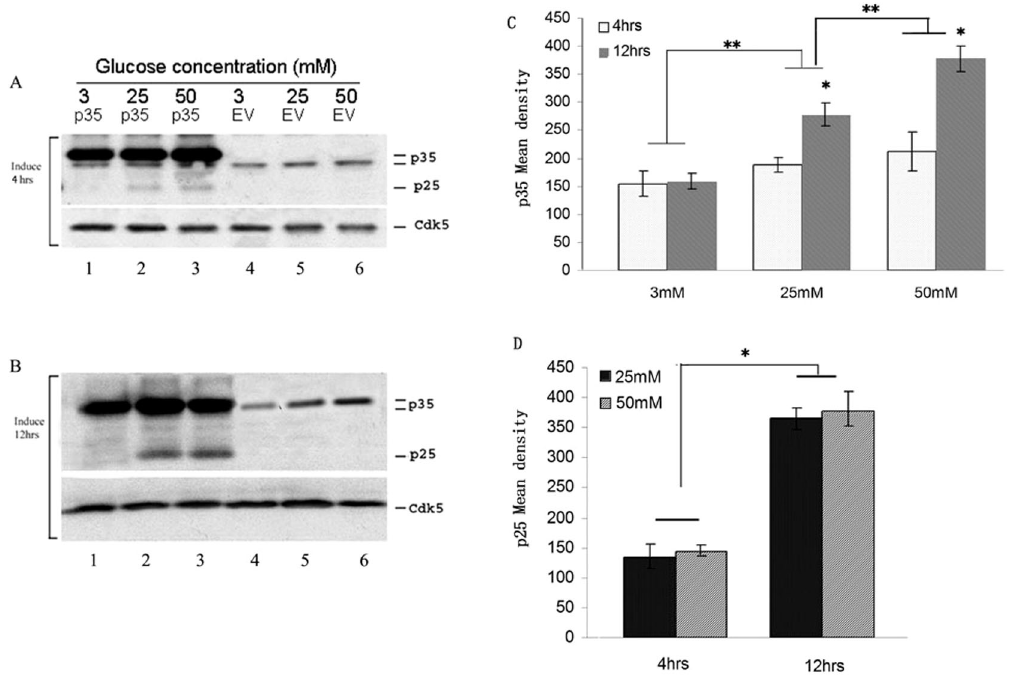
Figure 1. A time course and concentration course dependence of produced p25 expression in overexpression of p35 in HG stressed Min6 cells. A &B Overexpression of p35 produced p25 expression in Min6 cells stressed with HG (25 mM or 50 mM glucose) for 4 hrs (A, panel 1,lanes 2 and 3) and 12 hrs (B, panel 1, lanes 2 and 3). It exhibited a time dependence (Comparing A&B, penal 1, lanes 2 and 3). Cdk5 expressions were not affected by about stimulations (A&B, panel 2, lanes 1–6). C Quantification of Overexpression of p35. D Quantification of p25 expression produced by overexpressing of p35 plus stressed with HG in Min6 cells. (*shows time course comparison; ** shows dosage course comparison). Data represent mean 6 SE of three